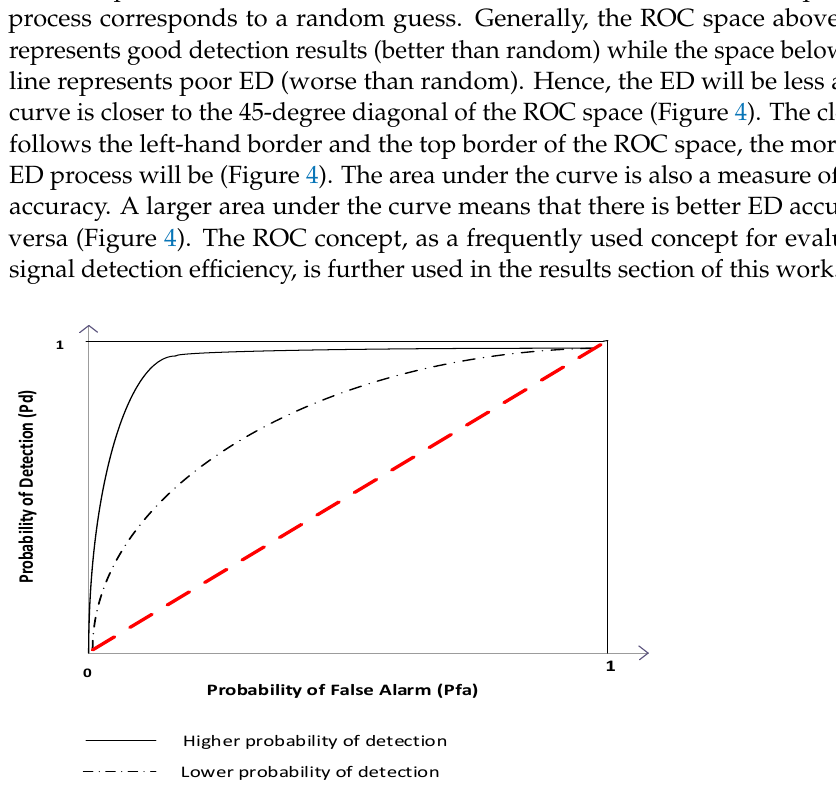
Figure 4. Example of ROC curves.